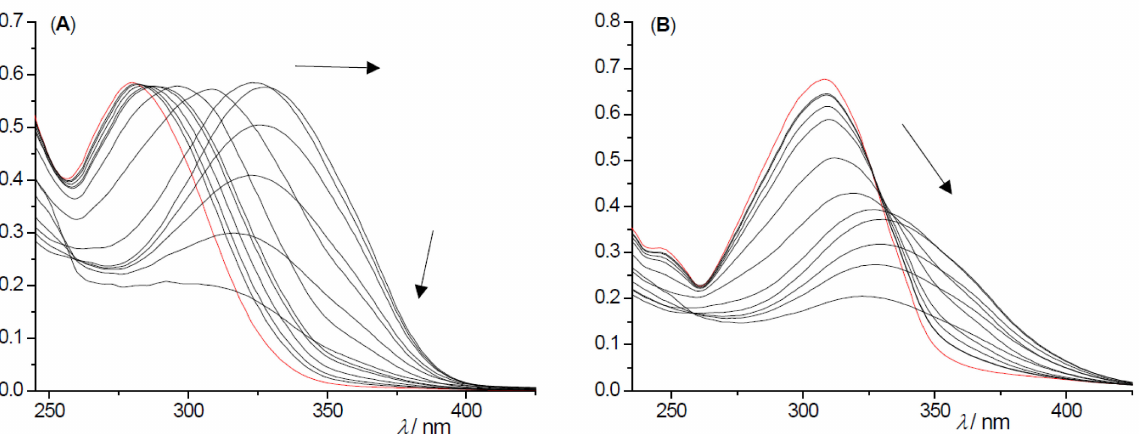
Figure 5. Spectral changes during the irradiation of cis - 2 ( A ) in ACN after 0 (red), 2, 4, 8, 16, 32, 64, 128, 256, 512, 1024, 2048 and 4096 s; ( λ ir = 313 nm, l = 1 cm) and trans - 2 ( B ) in ACN after 0 (red), 2, 4, 8, 16, 32, 64, 128, 256, 512, 1024 and 2048 s; ( λ ir = 313 nm, l = 1 cm).